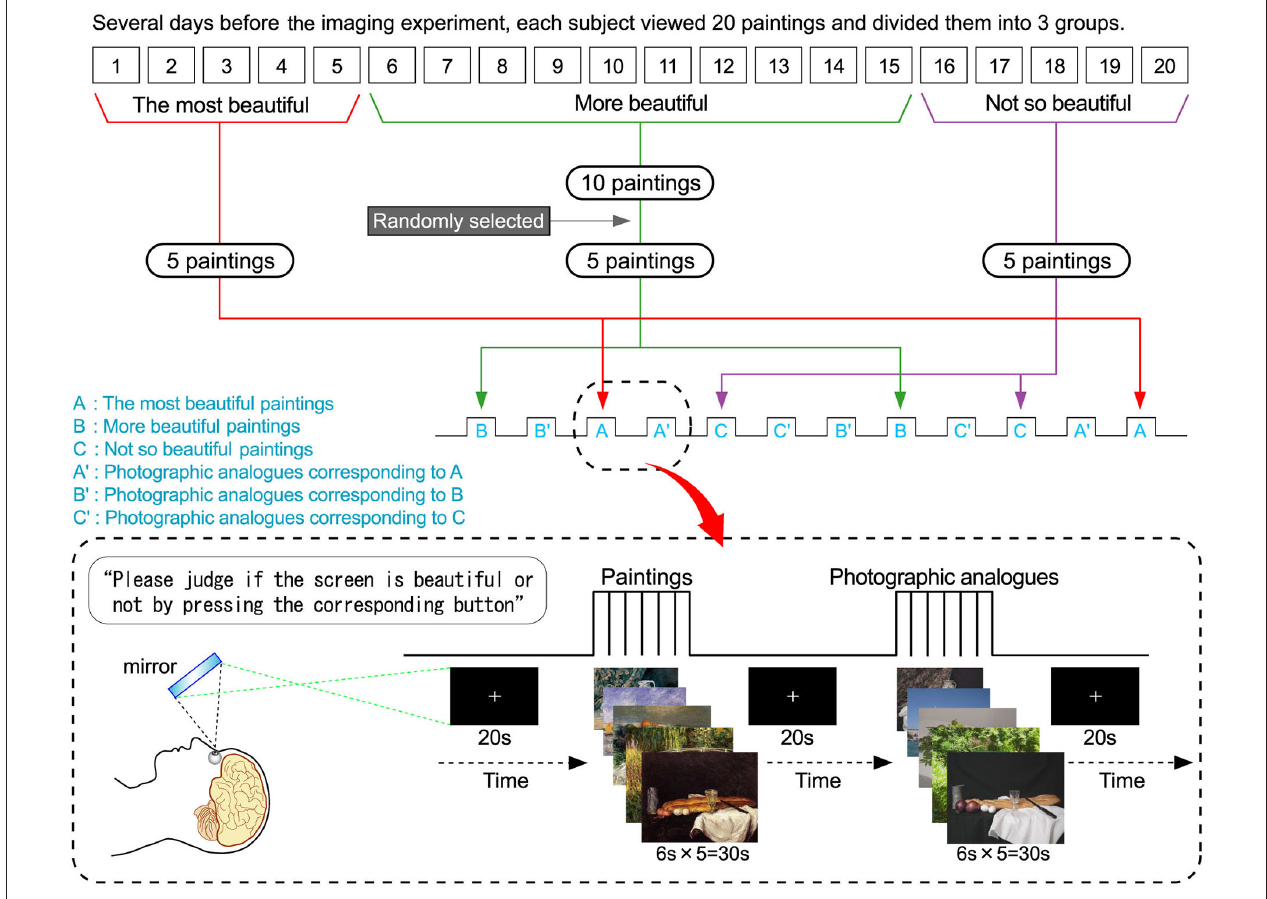
imaging experiment. Three painting blocks were presented to the subjects comprising the most beautiful (block A), more beautiful (block B) and not so beautiful (block C) while another 3 photographic analog blocks labeled A’, B’, and C’ were presented that corresponded to (or imitated) block A, B, and C, respectively. These photographs (i.e., photographic analogs) were used as a control for the imaging experiment. Prior to each block, a fixation cross was presented for 20 s. The sequence of the presentation of the blocks was B, B’, A, A’, C, C’, B’, B, C’, C, A’, and A. Subjects were instructed as follows: “Please judge if the screen is beautiful or not by pressing the corresponding